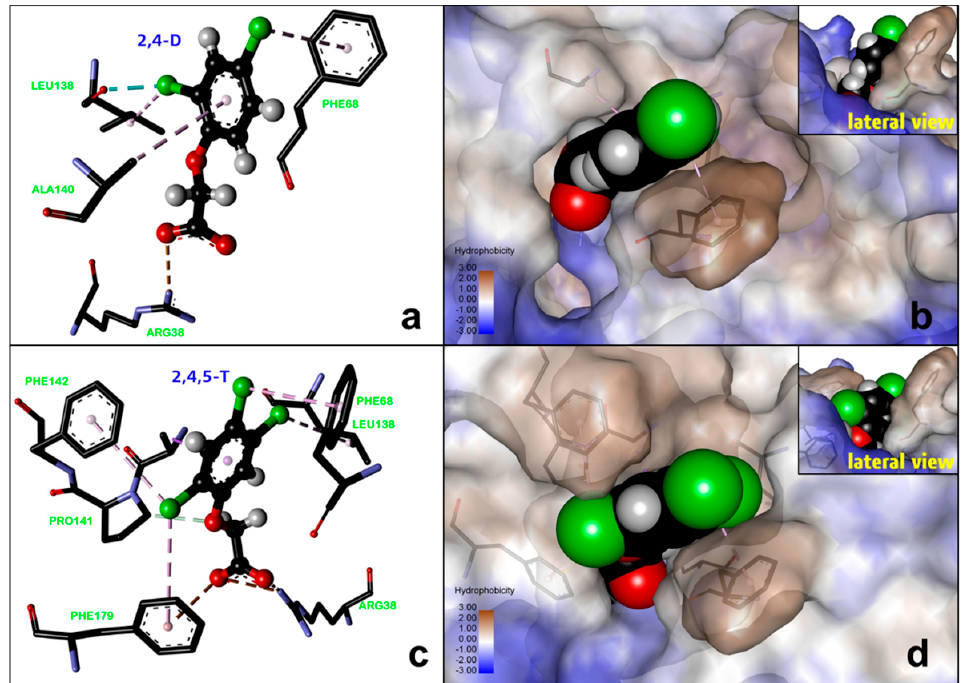
Figure 2. Left: Calculated 3D structure for the interaction of 2,4-D ( a ) and 2,4,5-T ( c ) with the active site of HRP. Right: Tertiary structure of HRP with 2,4-D ( b ) and 2,4,5-T ( d ) bound to the active site. Inset: lateral view (rotated ~90° from the above).